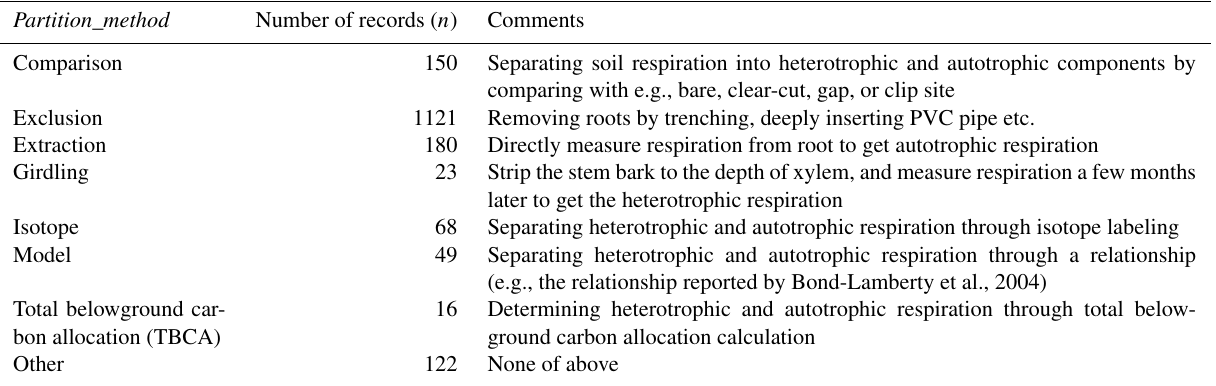
Table 3. Summary of standardized partition method ( Partition_method ) in SRDB-V5.